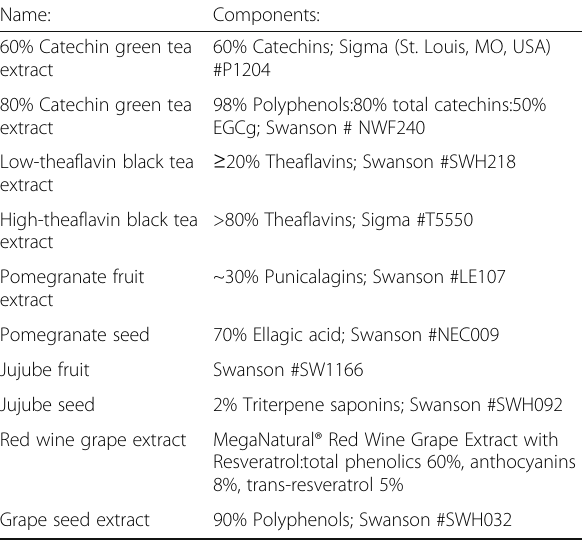
Table 1 Sources of food-based commercial test products evaluated against pathogenic